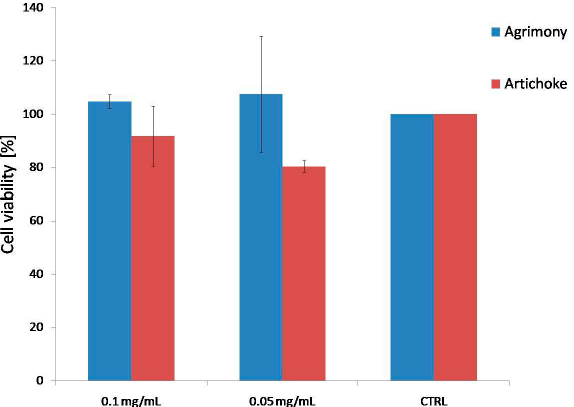
Figure 1. Effect of agrimony and artichoke (0.1 mg/mL and 0.05 mg/mL) on cell viability.